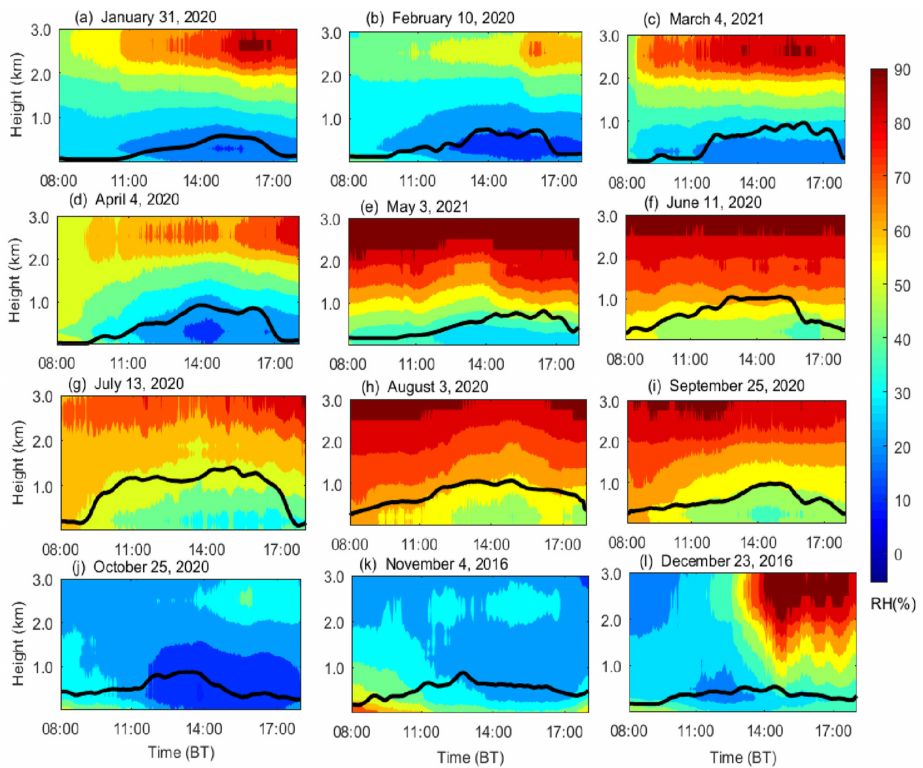
Figure 4. Spatial–temporal evolutions of relative humidity during typical haze events; the black line is the variation in BLH with